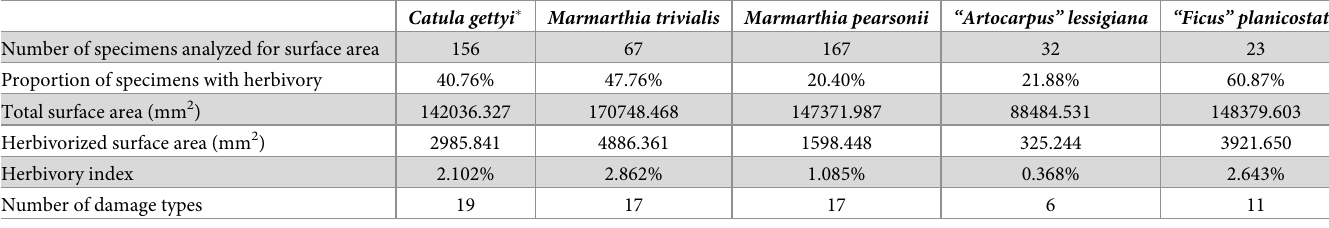
Table 2. Comparisons of herbivory between Late Cretaceous taxa in the family